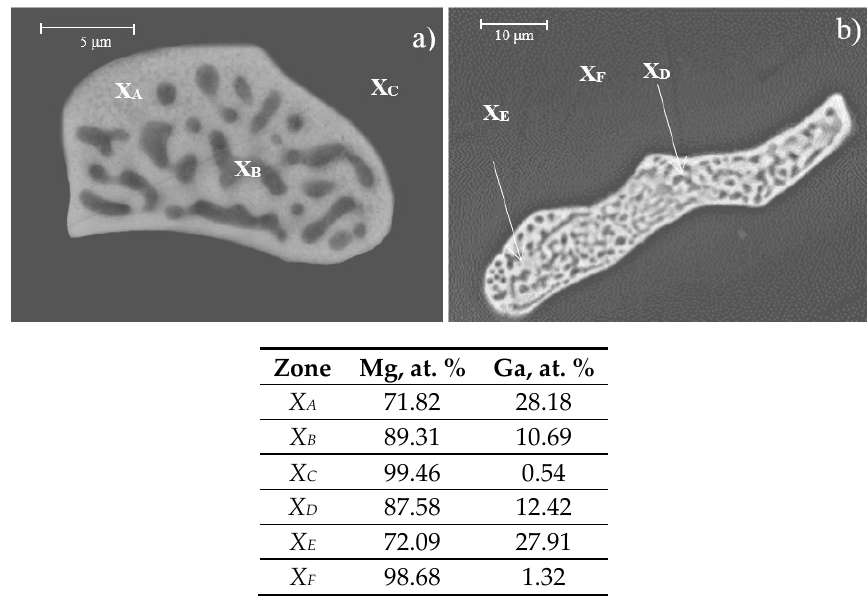
Figure 2. SEM images of precipitates in the as-cast Mg-Ga alloys, ( a ) Mg-0.375Ga alloy, ( b ) Mg-1.5Ga alloy, and corresponding EDS analysis.